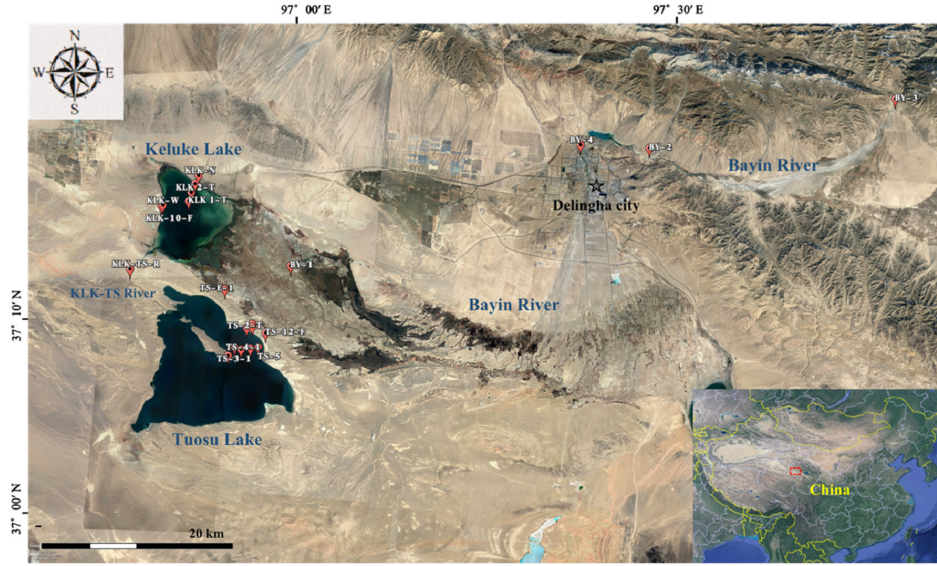
Figure 1. Study Sites in Qaidam